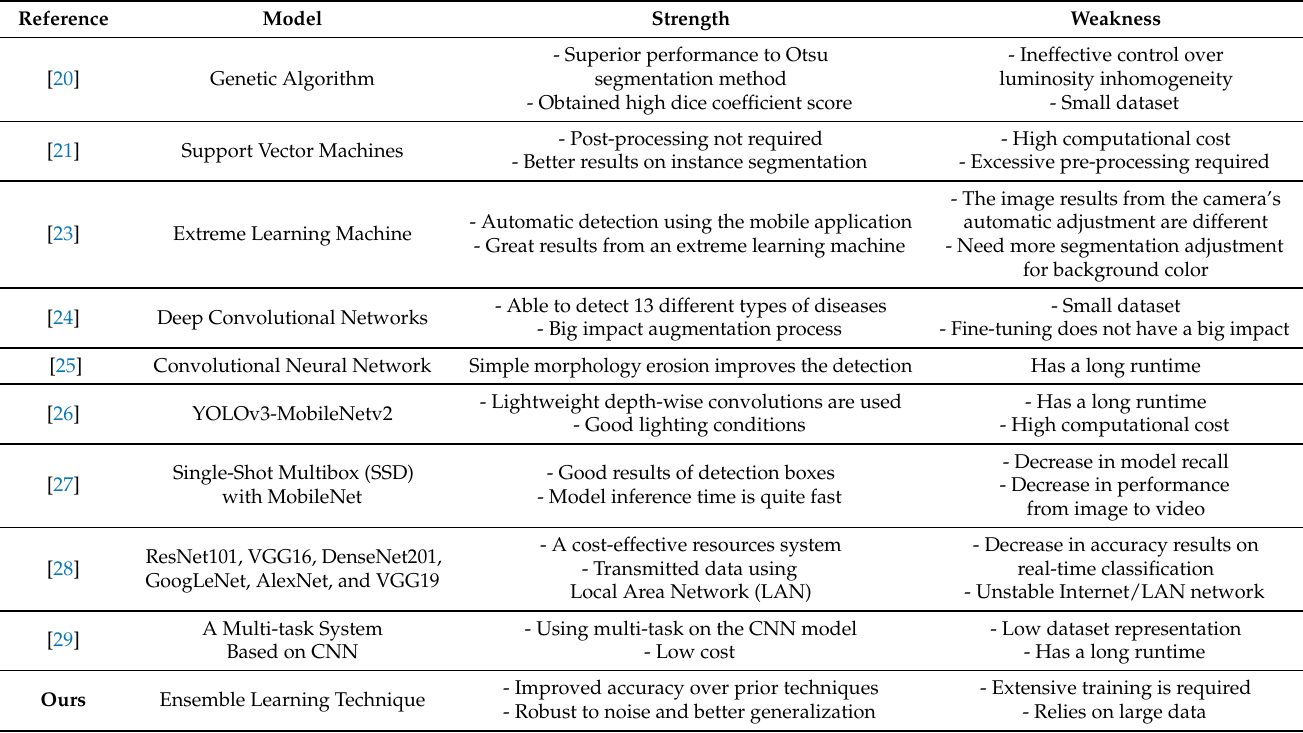
Table 1. Detailed analyses of the proposed and state-of-the-art studies.